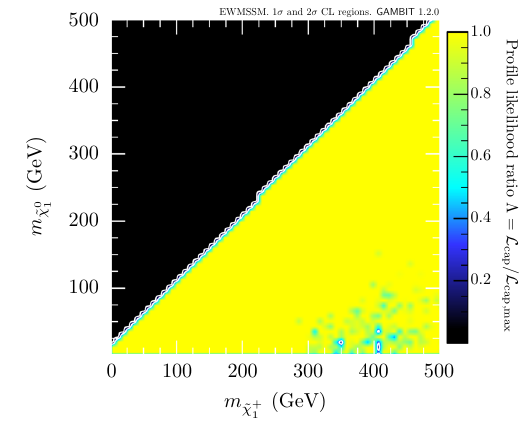
, m ) plane. The capped ˜ χ 0 1 1